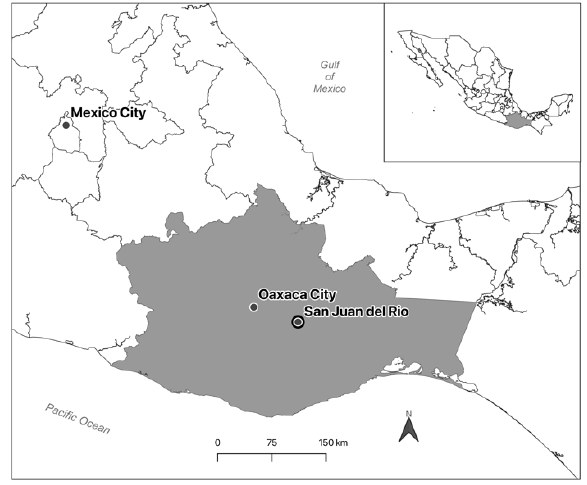
Figure 1. Location of San Juan del Río, Oaxaca (source: INEGI. Marco Geoestadístico.